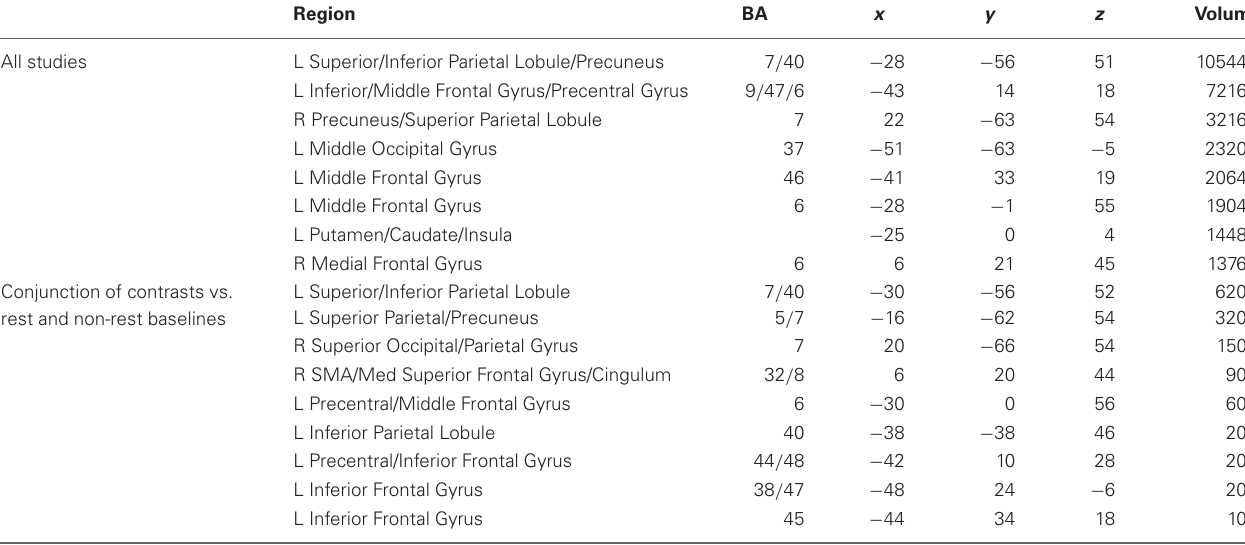
Table 2 | Weighted centers of clusters in the general imagery ALE analysis.